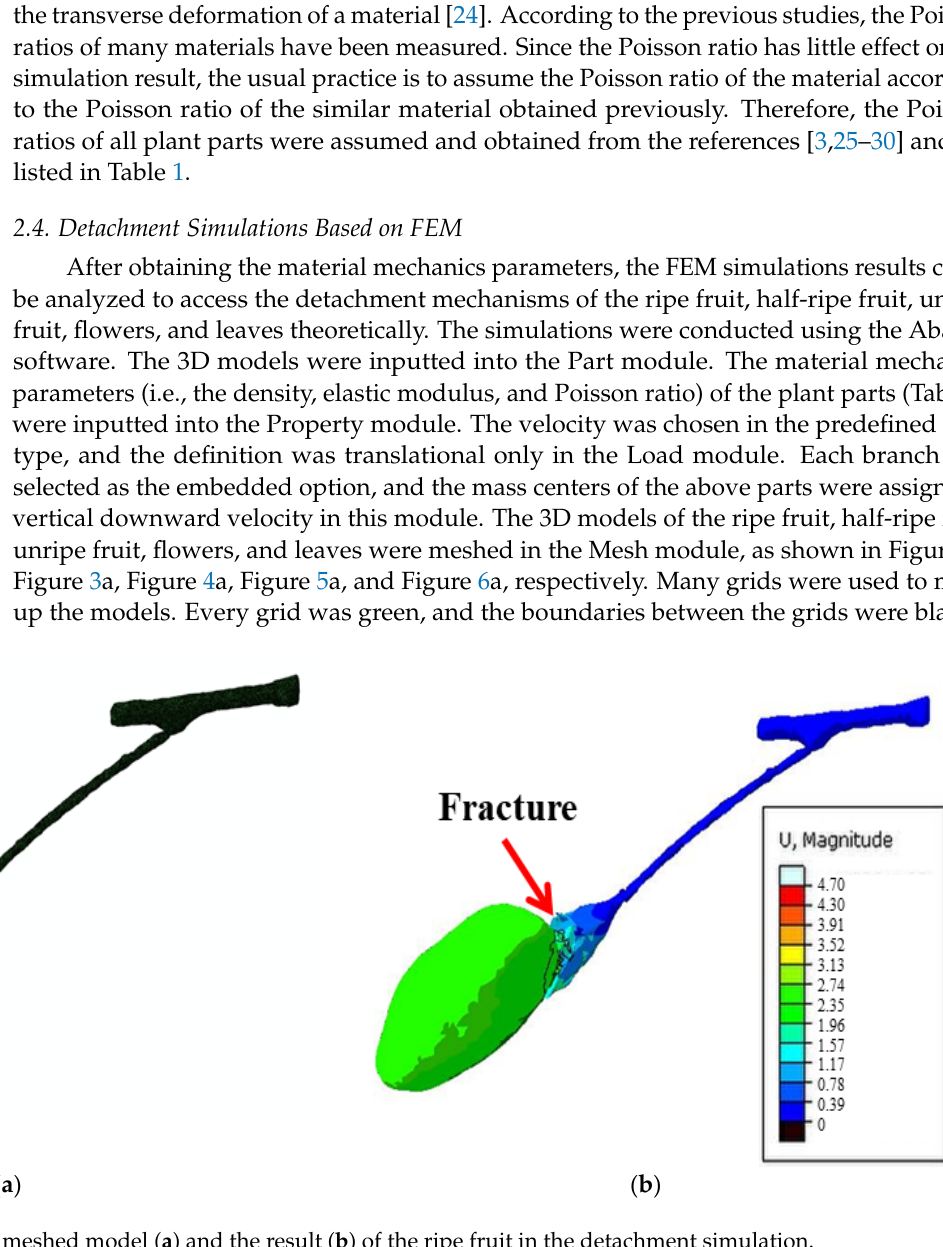
( a ) ( b ) Figure 3. The meshed model ( a ) and the result ( b ) of the half-ripe fruit in the detachment simulation.